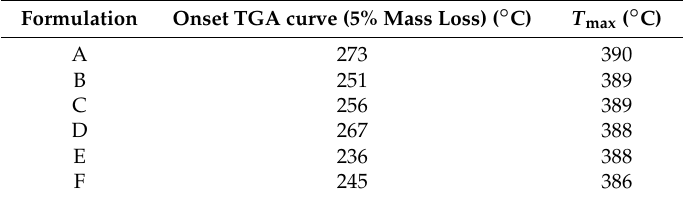
Table 4. TGA results for each cured material.